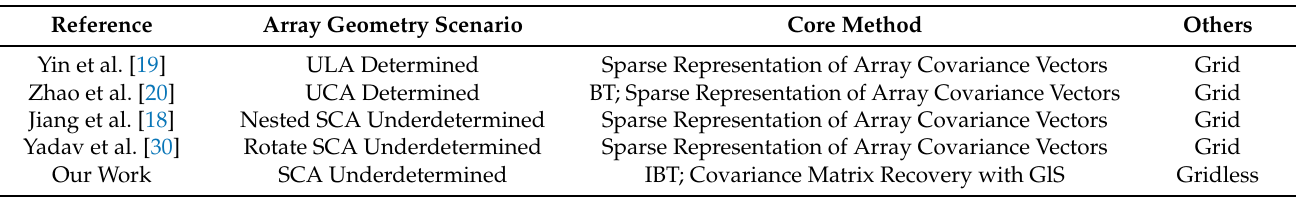
Table 1. Differences and